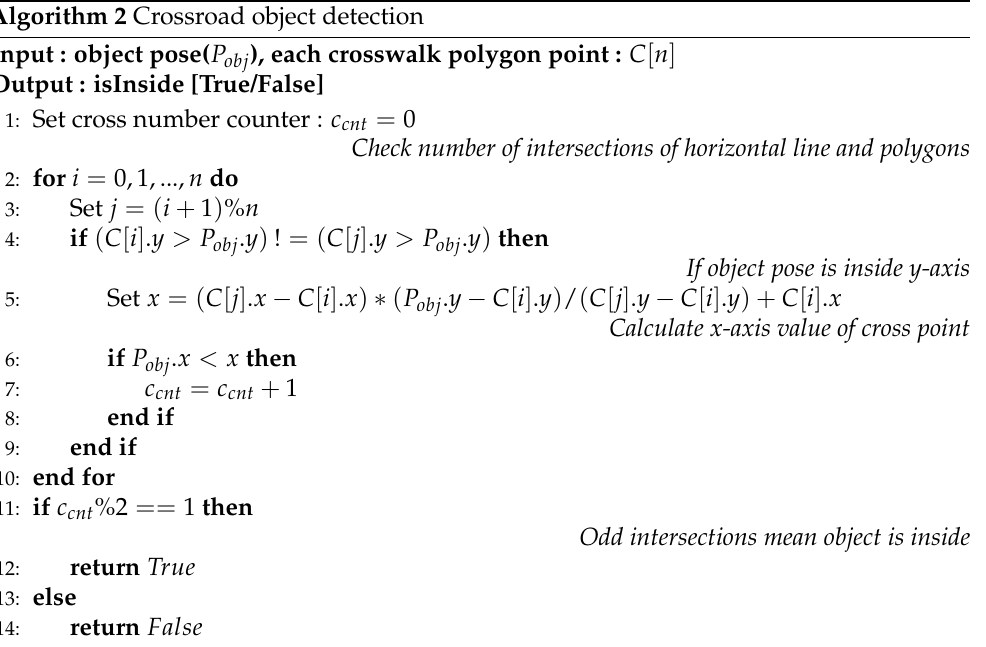
Algorithm 2 Crossroad object